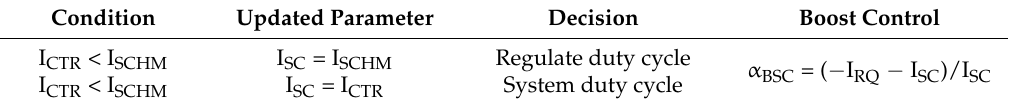
Table 4. SCap boost control.